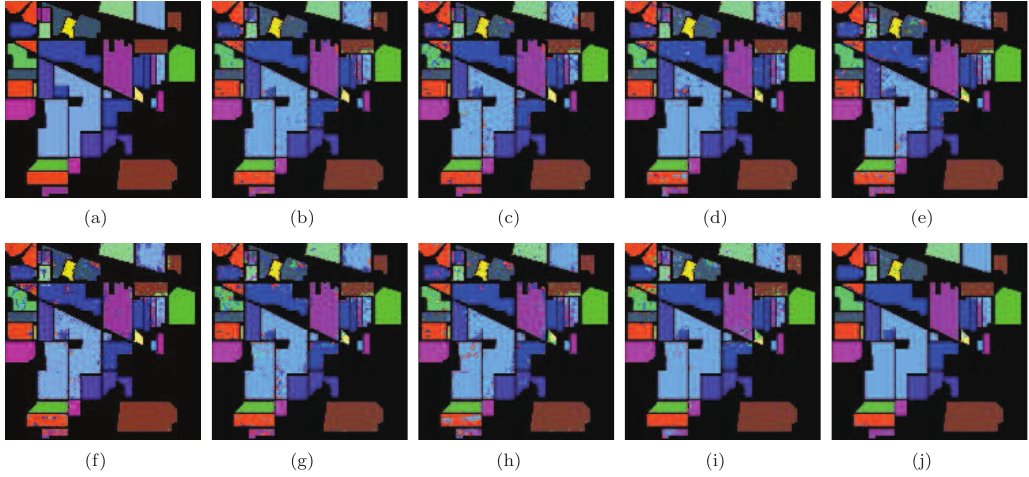
Figure 13. Classification maps of different methods with SVMCK on the Indian Pines data set. ( a ) Ground truth; ( b ) Baseline (93.9%, 0.930); ( c ) PCA (91.8%, 0.907); ( d ) NPE (92.0%, 0.908); ( e ) LPP (91.0%, 0.897); ( f ) SDE (91.1%, 0.899); ( g ) LFDA (90.9%, 0.896); ( h ) MMC (89.9%, 0.885); ( i ) MFA (93.5%, 0.926); ( j ) LGSFA (98.1%, 0.978). Note that OA and KC are given in